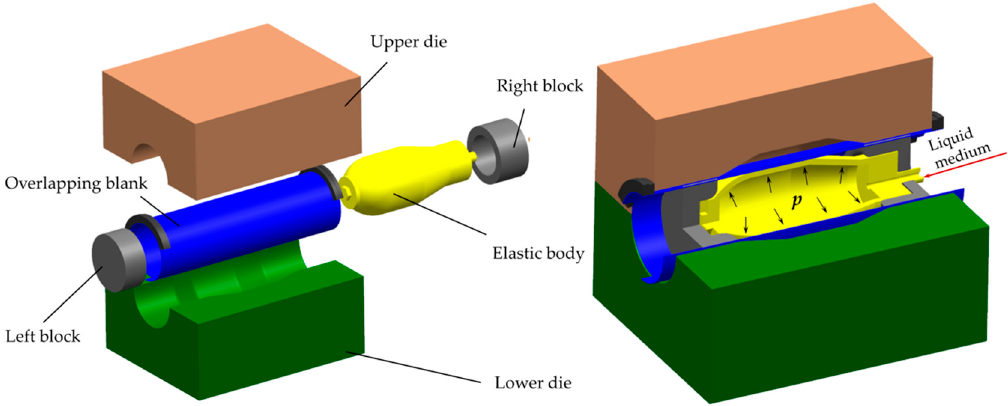
Figure 5. Schematic diagram of the experimental setup.